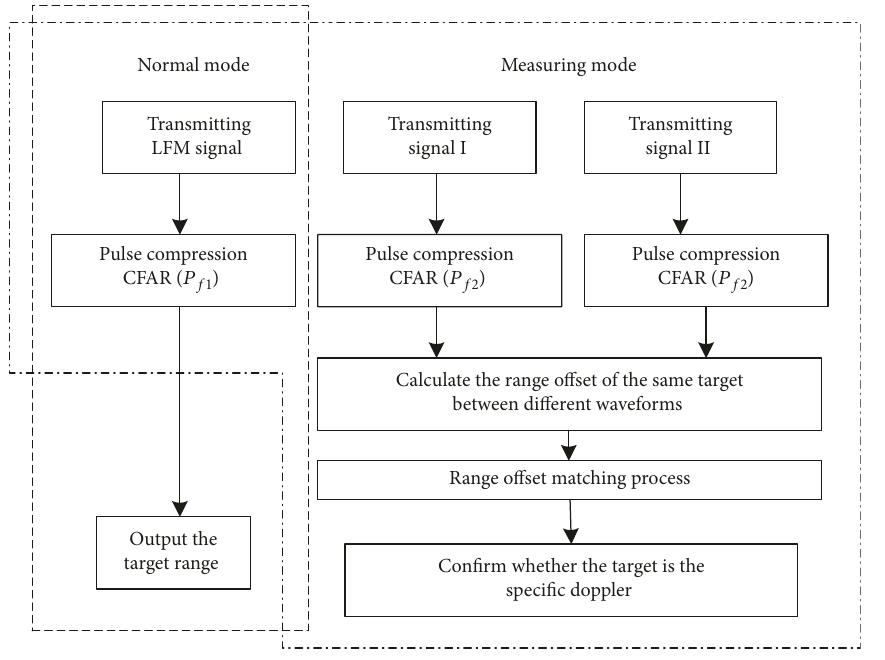
Figure 4: Flow chart of the proposed application technique. Table 1: Signal parameters and target positions (in theory).